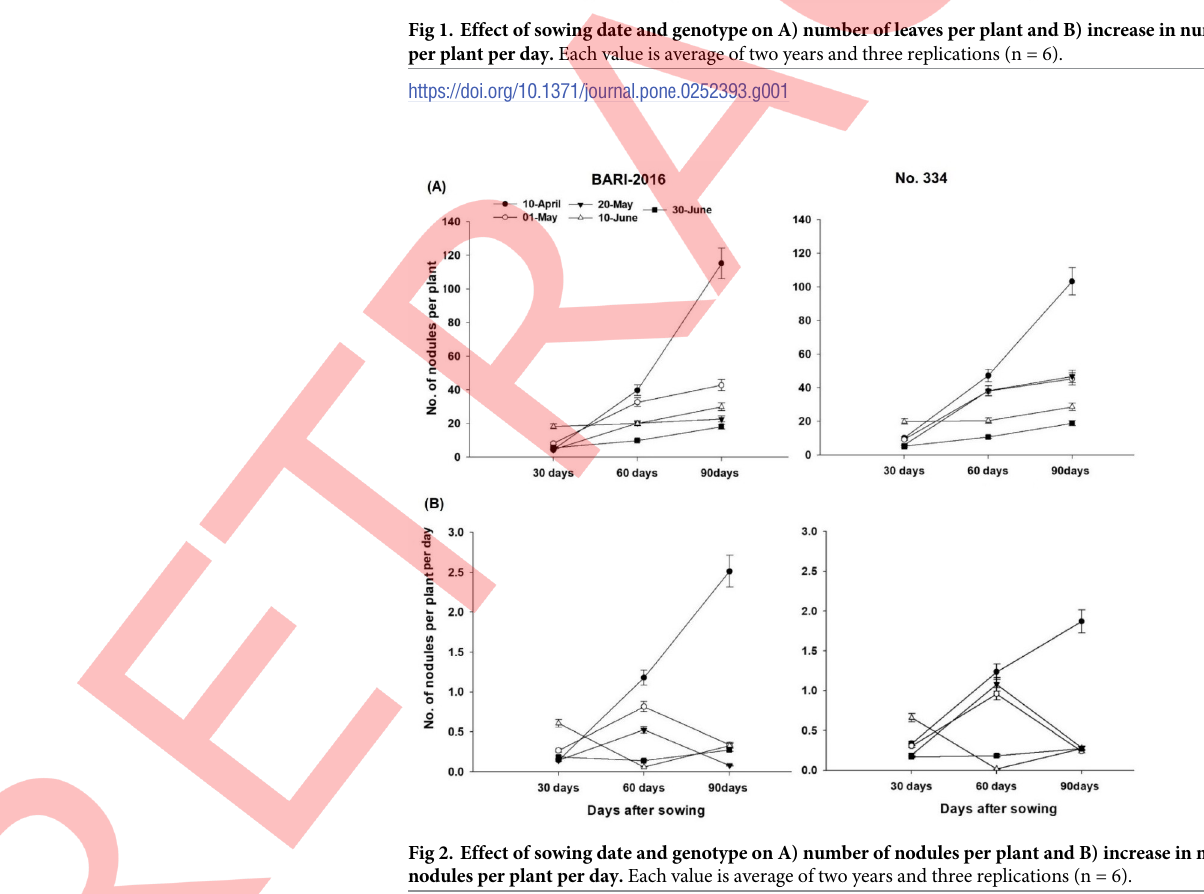
Fig 2. Effect of sowing date and genotype on A) number of nodules per plant and B) increase in number of nodules per plant per day. Each value is average of two years and three replications (n = 6).